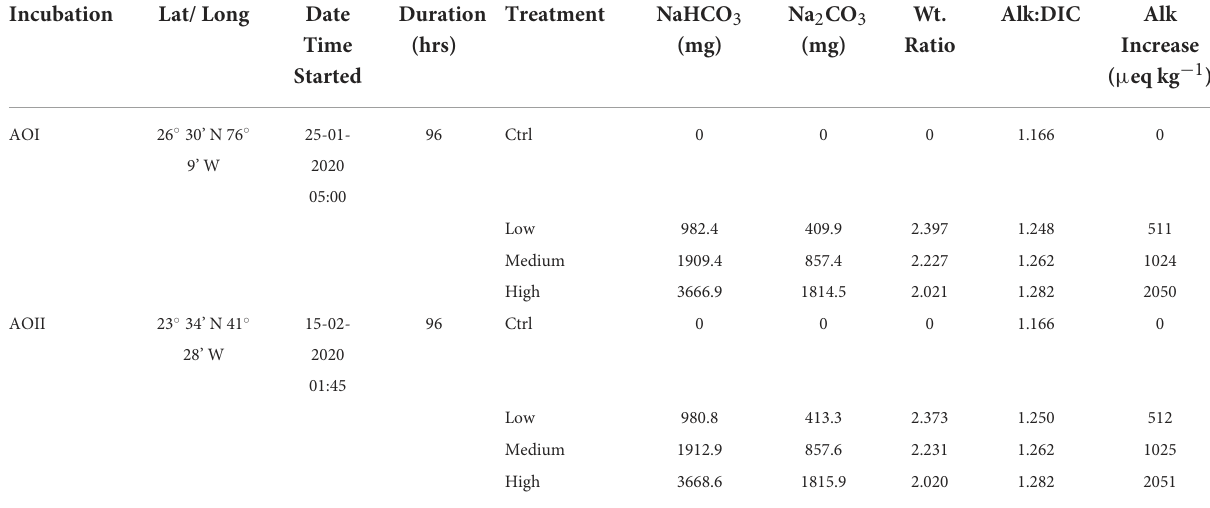
TABLE 1 Experiment details for both locations, including alkalinity spike